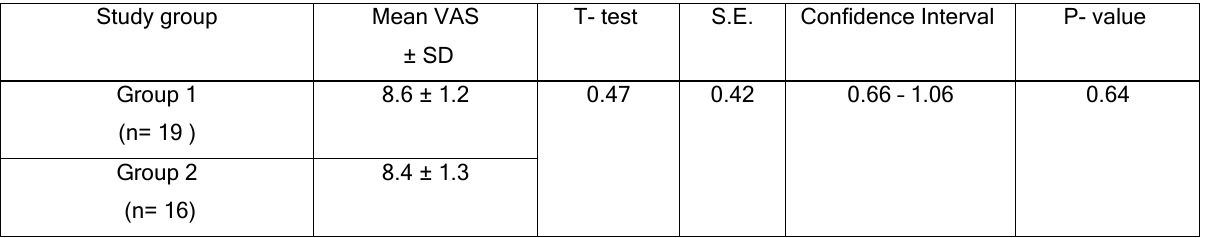
Table (2): A comparison between study groups in current study regarding VAS before